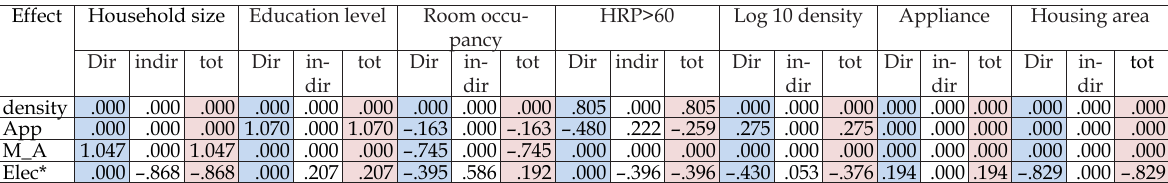
Table 11. Direct, indirect and total impact of variables on per-capita electricity